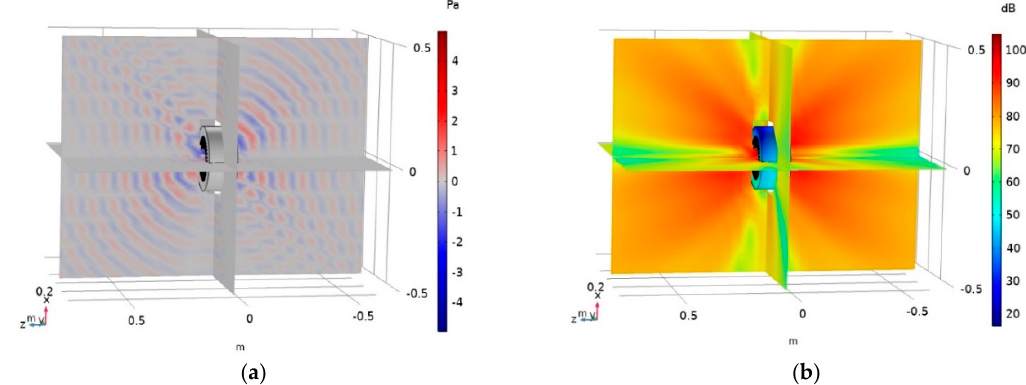
Figure 8. Sound pressure level in dB outside the motor at 2016 Hz .